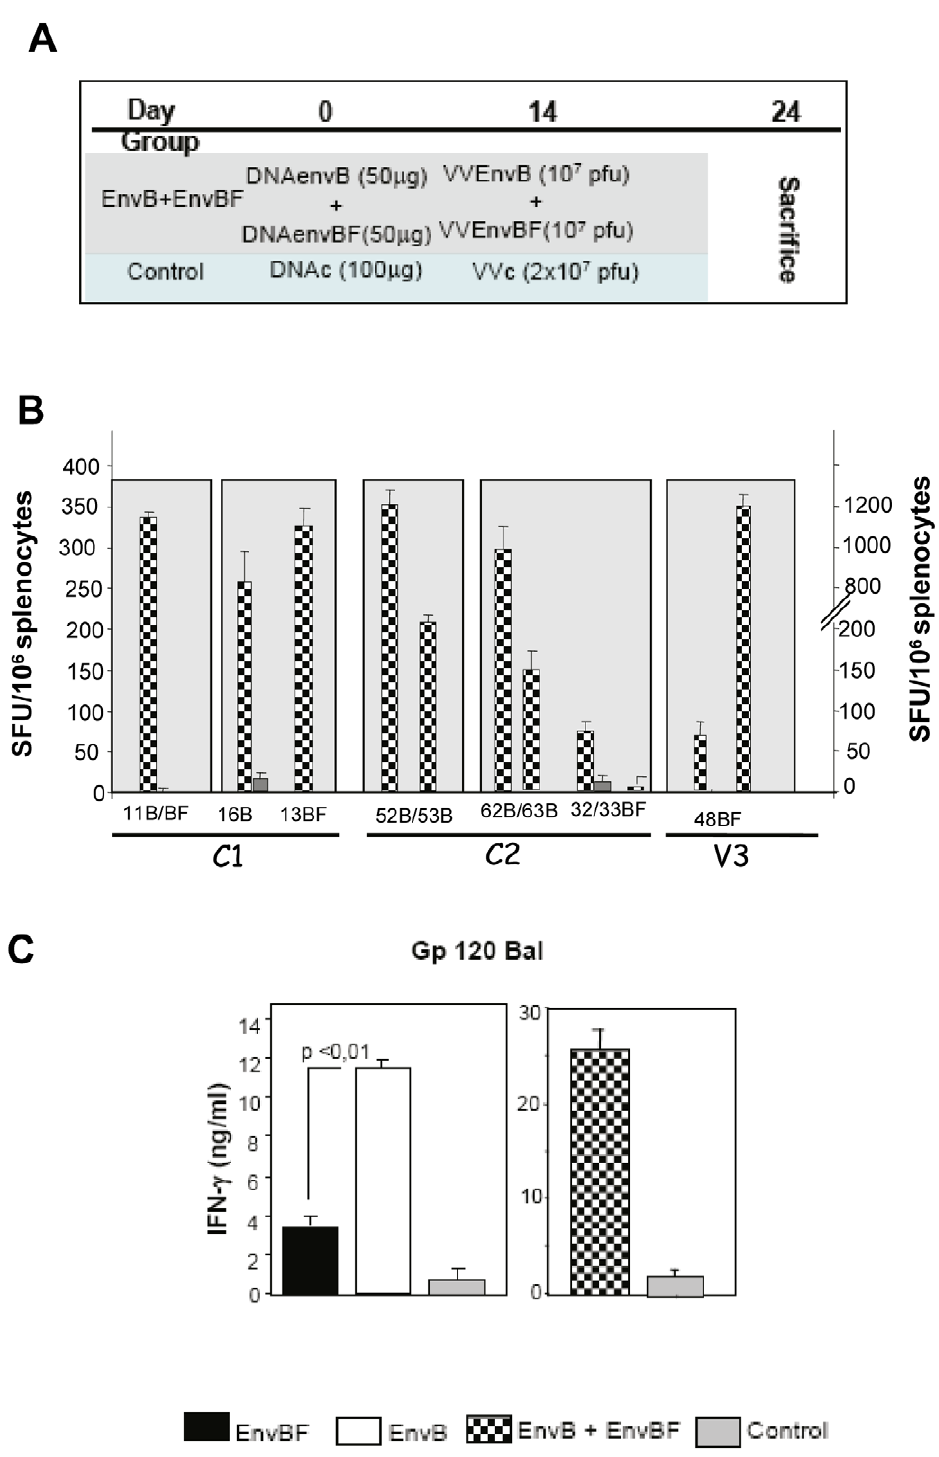
Figure 7. A mixed immunization regime combining both clades (B and BF) induced a broad immune response. A ) Immunization scheme describing viral and DNA doses applied. B ) Ten days after the boost immunization, T cell response induced after the mixed immunization was analyzed against the different B and BF peptides targeted after the single-clade immunizations. Peptides were grouped according to its localization within each protein region; # : indicates that positive responses were found in one of two experiments. C ) Ten days after the boost, splenocytes from mice immunized as its is depicted in A or in Figure 2A were stimulated with gp120 Bal (1 m g/ml) during 72 hrs and afterwards IFN- c levels in the supernatant were quantified.